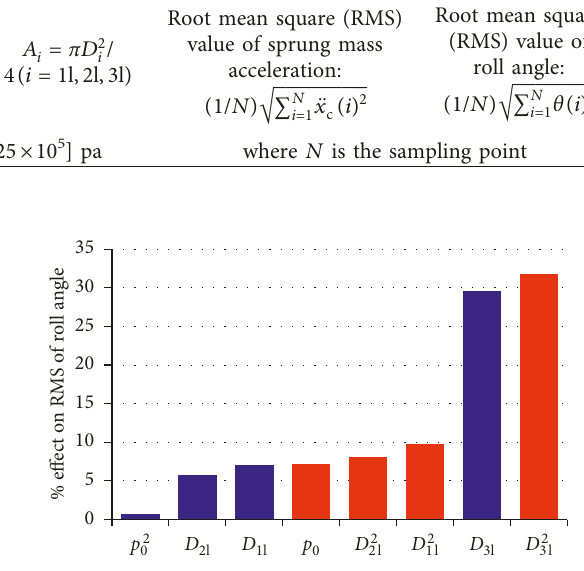
Figure 5: Pareto chart in the bounce mode. Figure 6: Pareto chart in the roll